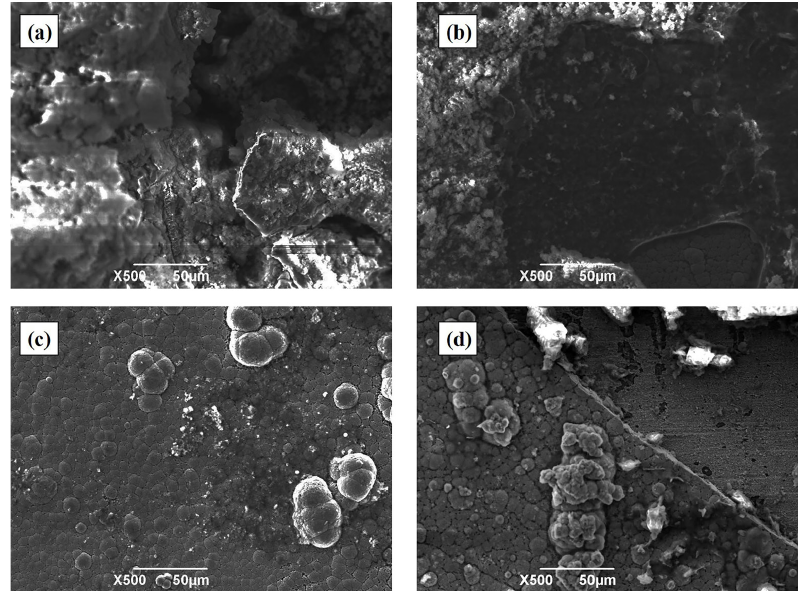
WO concentrations immersed in 3.5 wt.% NaCl solution for 2 4